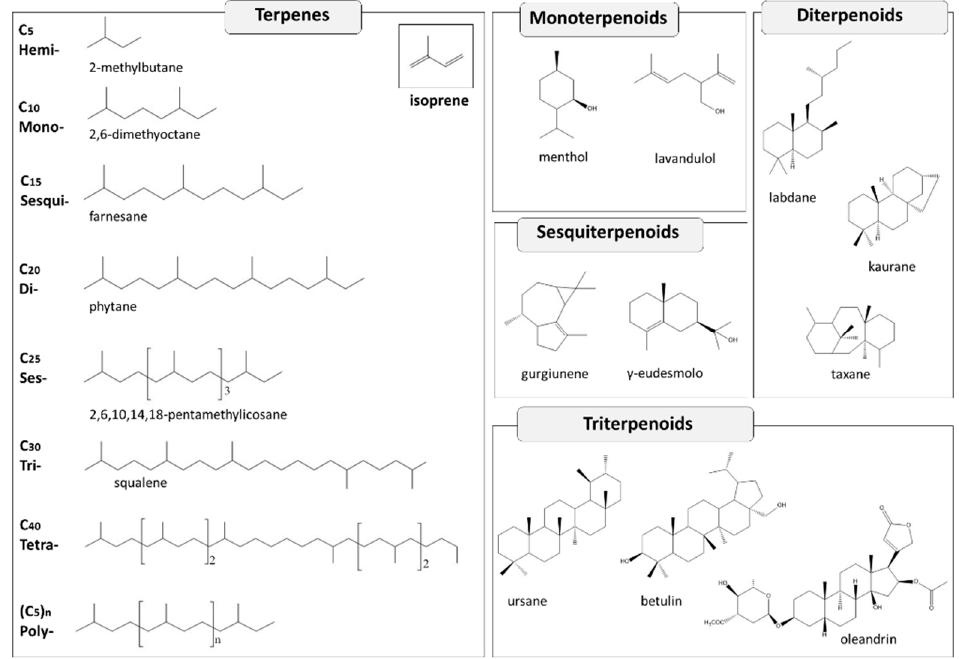
Figure 3. Some examples of terpene chemical structures and classification according to the number of isoprene units contained in the structure.